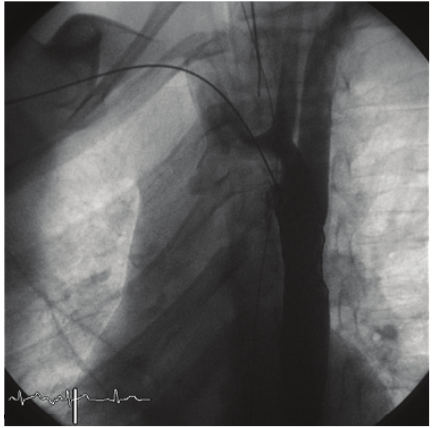
Figure 3: 30 ∘ left anterior oblique view: stent successfully